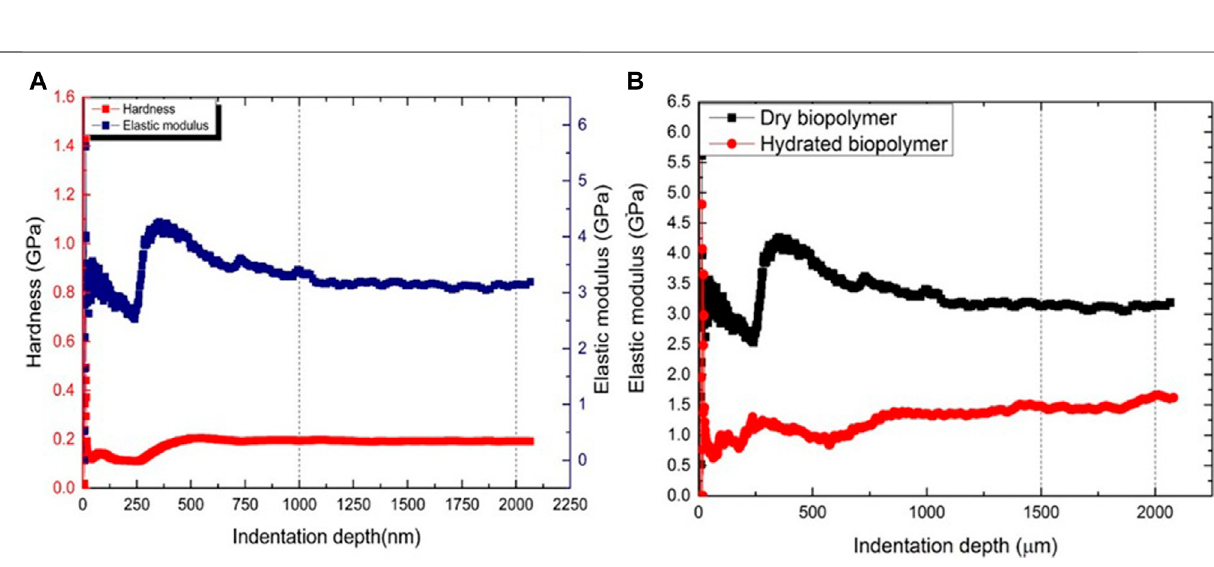
Frontiers in Materials |